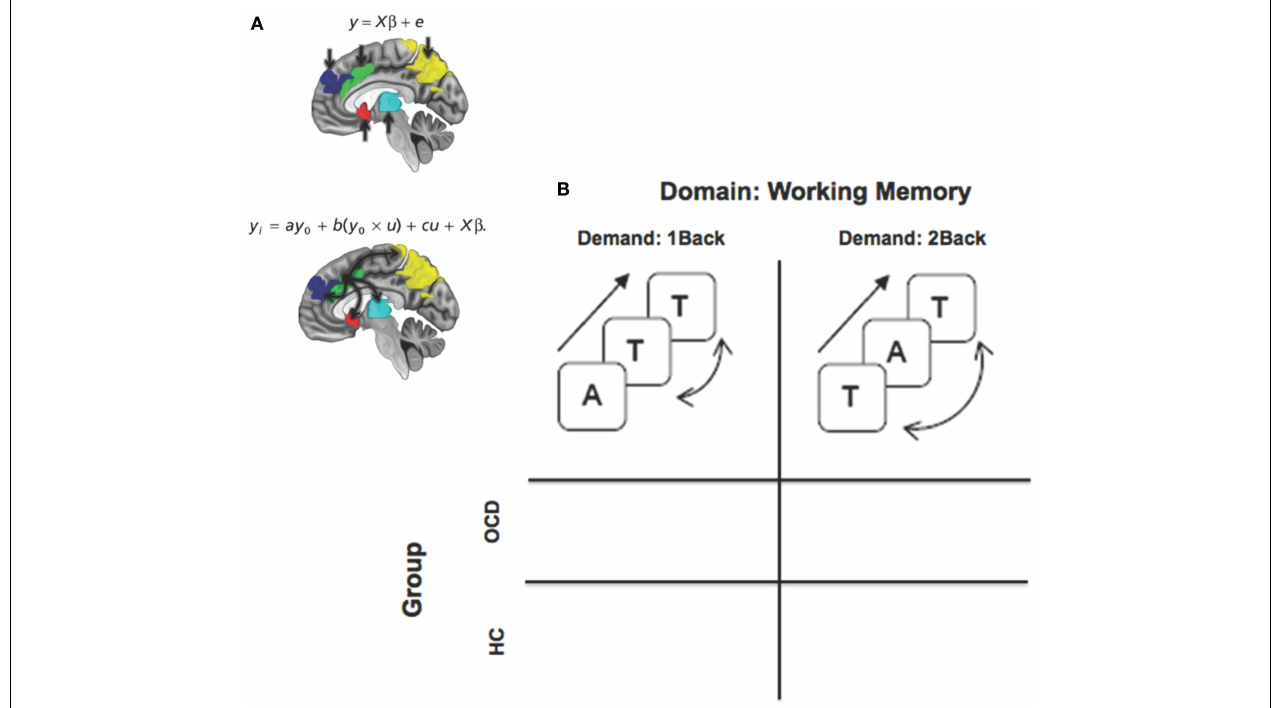
modulation of targets in the task-oriented ( u = working memory > rest) context.The regions of interest are schematically depicted on the mid-sagittal surface.The second figure schematically depicts the modulatory effects of the dACC assessed using psychophysiological interaction. (B) The factorial design space used for the study that assessed the effects of task-demand (1Back vs. 2Back) crossed with